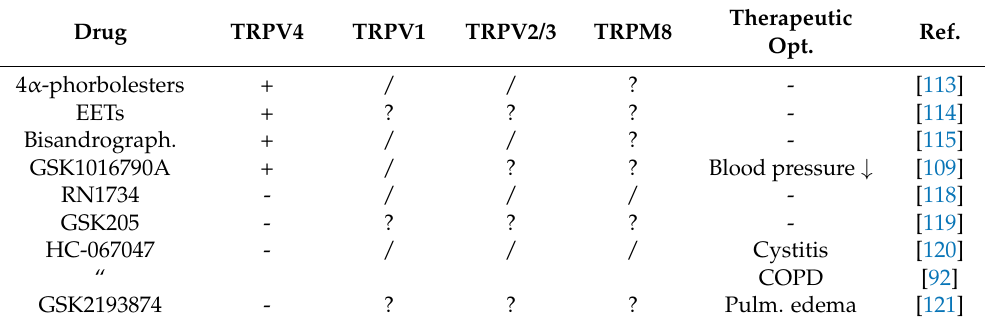
Table 4. Selected compounds activating or inhibiting TRPV4.